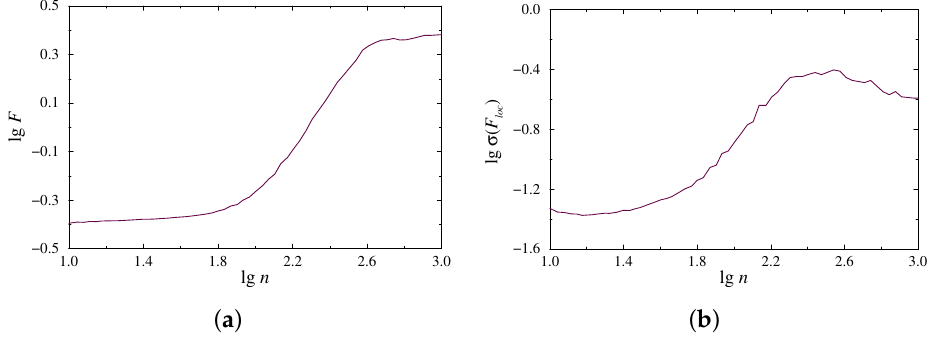
Figure 1. Examples of dependences F ( n ) ( a ) and σ ( F loc )( n ) ( b ) on a double logarithmic plot for the model of paired nephrons in the case of synchronous chaotic